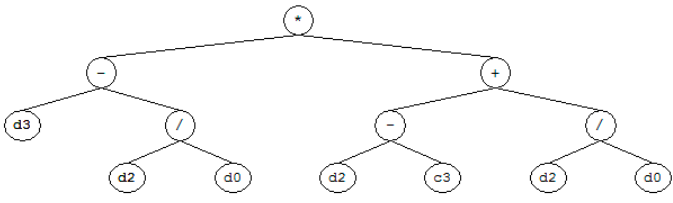
Figure 10. The third sub gene-expression tree.